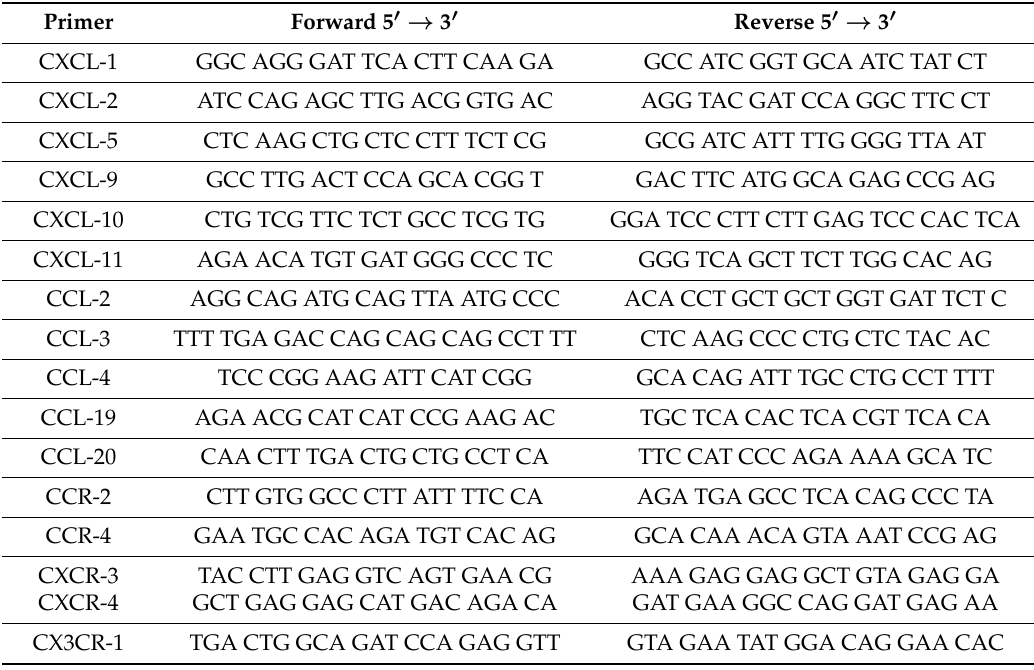
Table 1. Sequence of gene-specific primers used for quantitative RT-PCR